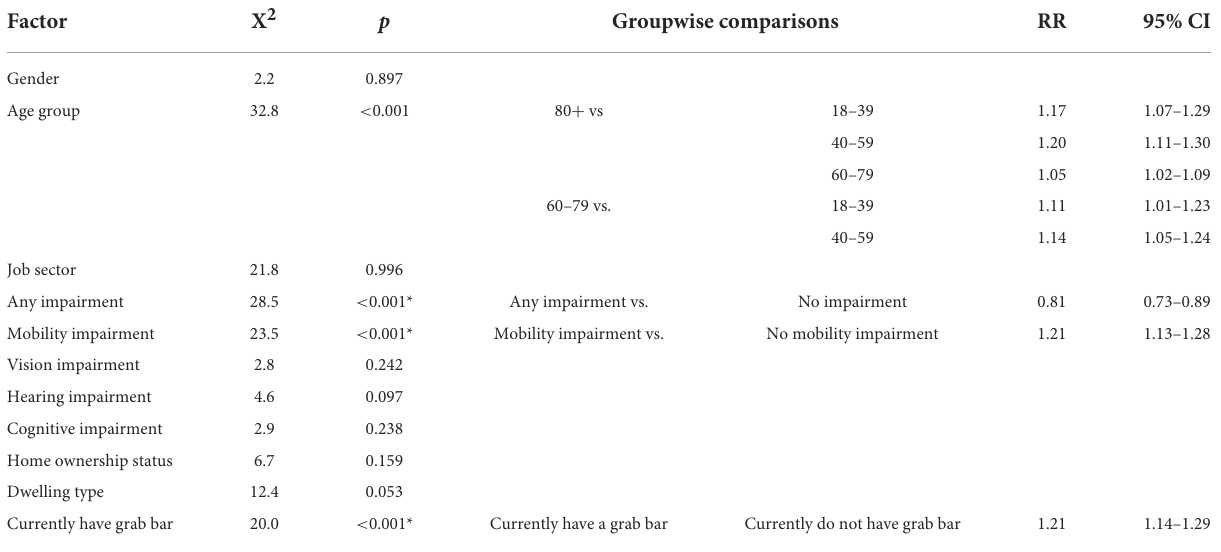
TABLE 6 Probability of using a grab bar installed in the home (GB4): Comparison by respondent demographic characteristics, disability status and living environment. Factor X 2